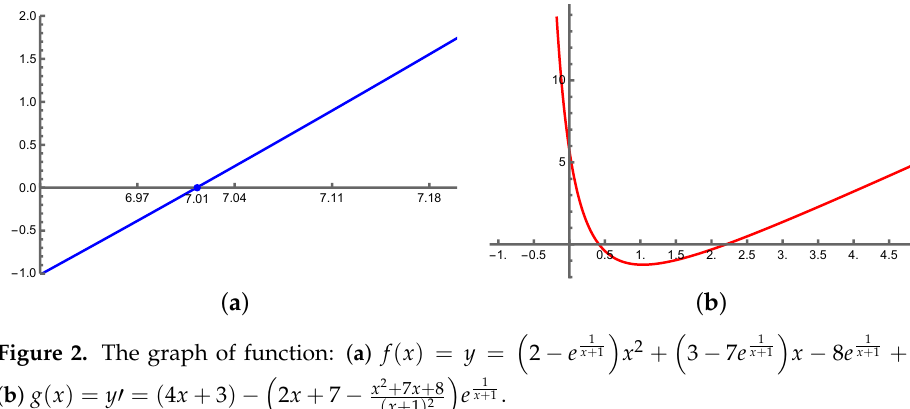
Figure 2. The graph of function: ( a ) f ( x ) = y = ( b ) g ( x ) = y (cid:48) = ( 4 x + 3 ) − Thus, y ( x ) is an increasing function for x >